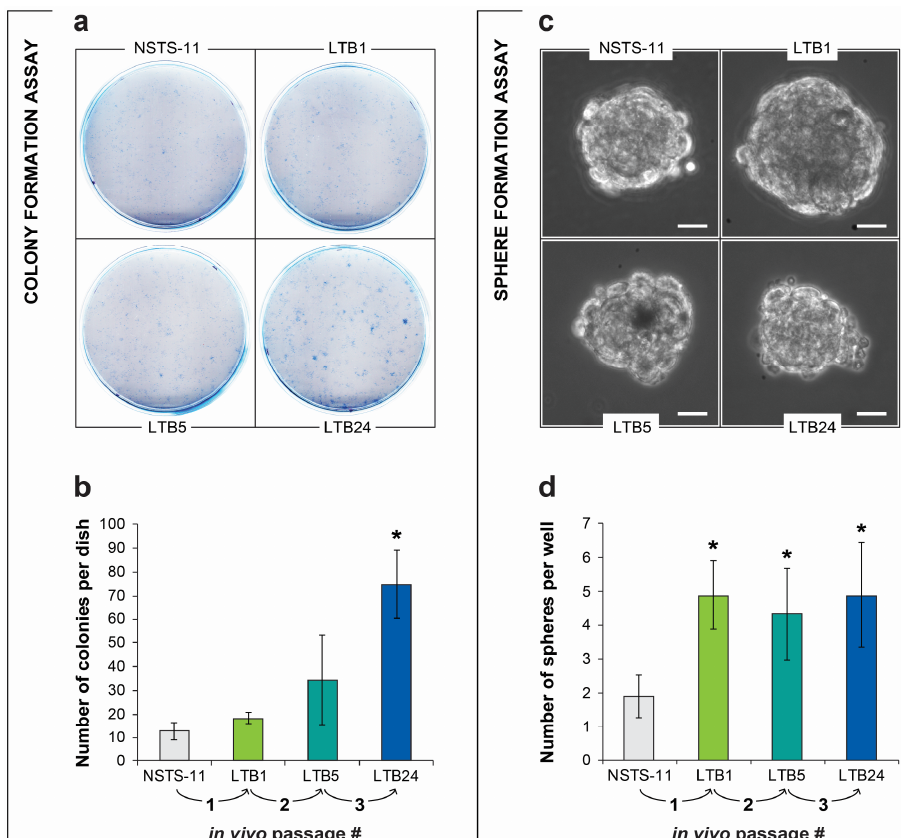
Figure 2. In vitro functional assays revealed an enrichment of cancer stem cells (CSCs) over in vivo passages. ( a ) Representative images of the colony formation assay. A total of 1000 cells were plated per culture dish and cultured for 8 days. ( b ) Quantification of the colonies (>50 cells per colony) formed by the parental NSTS-11 cells and the cells derived from the primary (LTB1), secondary (LTB5), and tertiary (LTB24) xenograft tumors. Data are presented as the mean ± SD of three independent experiments. ( c ) Representative images of rhabdospheres formed by the respective cell lines. Scale bars, 25 µm. ( d ) More than a two-fold increase in sphere formation capacity over in vivo passages. The number of spheres is presented as the mean ± SD of three independent experiments. * Significantly higher compared with the parental NSTS-11 cells ( p <